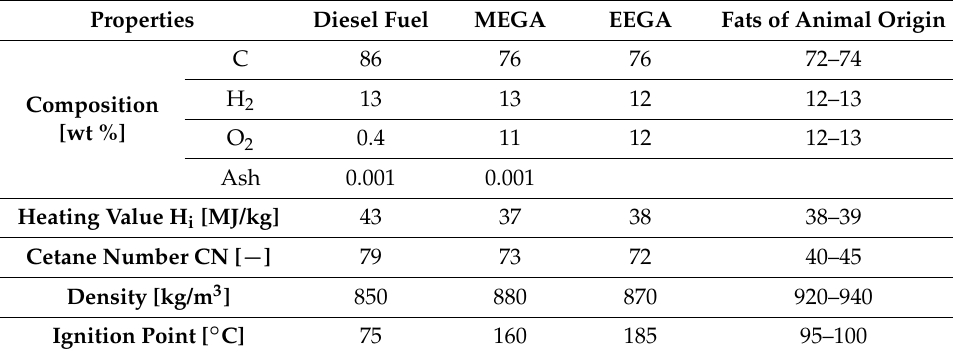
Table 1. Characteristics of diesel fuel, animal fat oils and animal fats